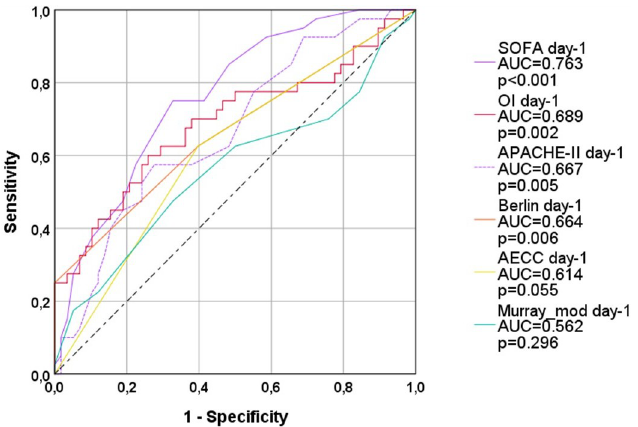
Fig 1. ROC-AUC regarding 28d-mortality (all patients; day 1). OI: oxygenation index; AECC: American European Consensus Conference; Murray_mod: modified Murray-score (sum of points without radiological points); AUC: area under the curve. APACHE-II: Acute Physiology And Chronic Health Evaluation; SOFA: Sequential Organ Failure Assessment.